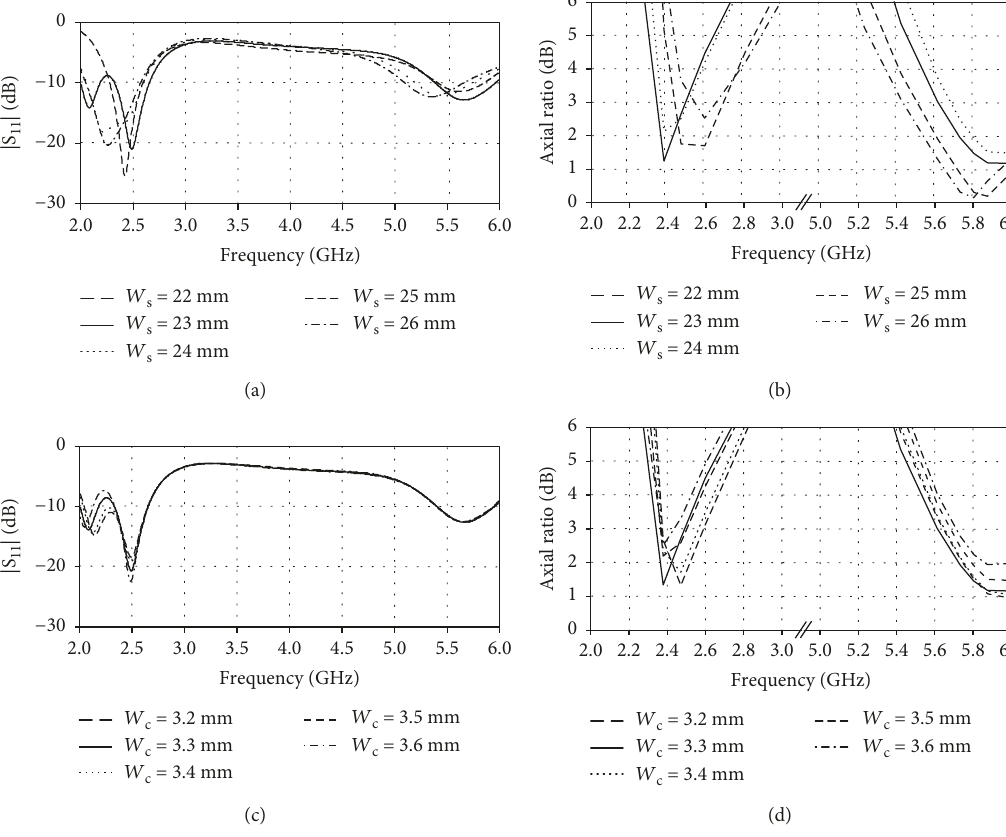
w S w s is varied, (c) 11 when c is varied,